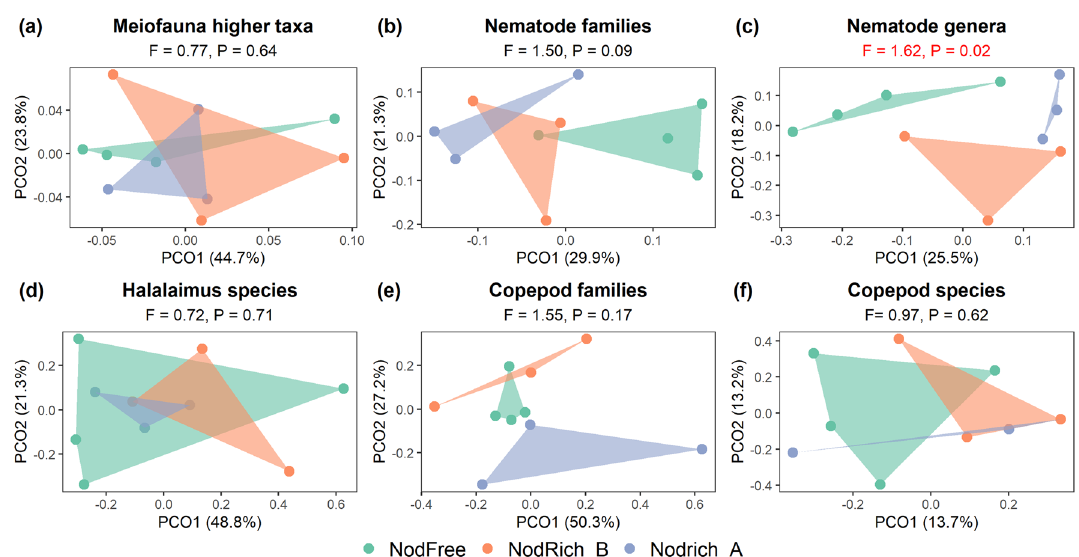
Figure 2. PcoA plots comparing taxonomic composition between the nodule-free (NodFree) and nodule-rich (NodRich_A and NodRich_B) stations (0–5 cm sediment depth). ( a ) Meiofauna higher taxa, ( b ) nematode families and ( c ) nematode genera, ( d ) Halalaimus species and copepod ( e ) families and ( f ) species. Convex hulls are drawn around samples from the same station. The F and P-values for the PERMANOVA tests are shown on top; for statistically significant tests, these are indicated in